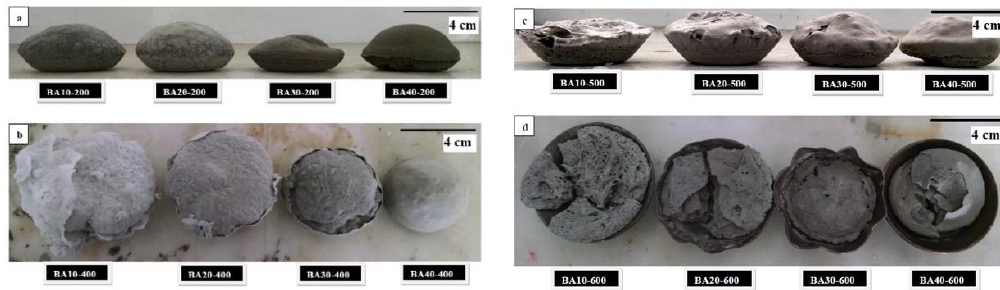
Figure 1. Thermal geopolymer foams (TGPFs) of different compositions cured at, ( a ) 200 o C; ( b ) 400 o C; ( c ) 500 o C; ( d ) 600 o C, right after demoulding.